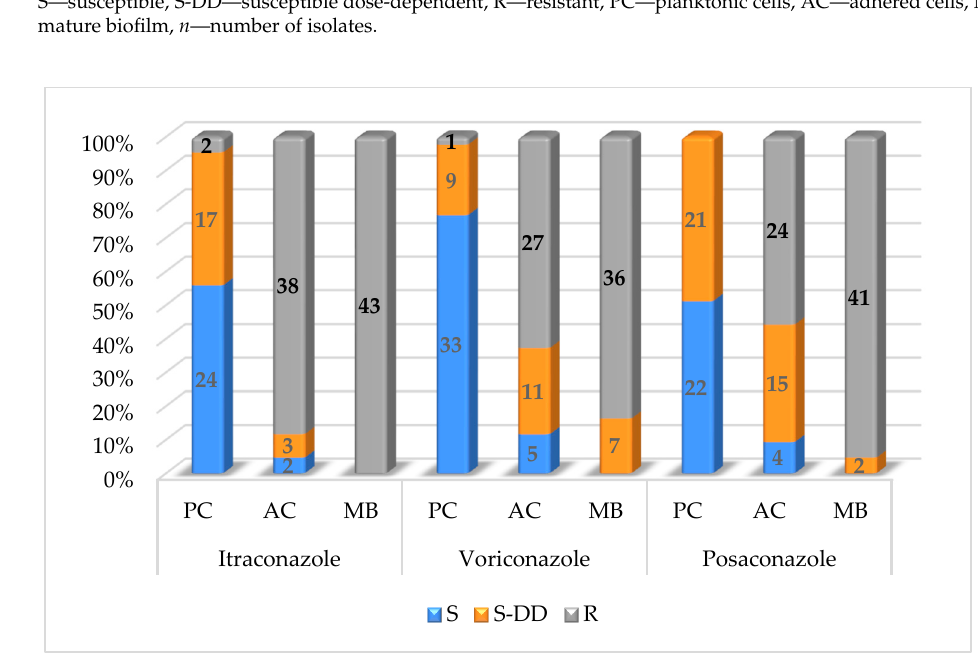
Figure 1. Susceptibility of planktonic cells (PC), adhered cells (AC) and mature biofilm (MB) of M. pachydermatis strains; S—susceptible, S-DD—susceptible dose-dependent,